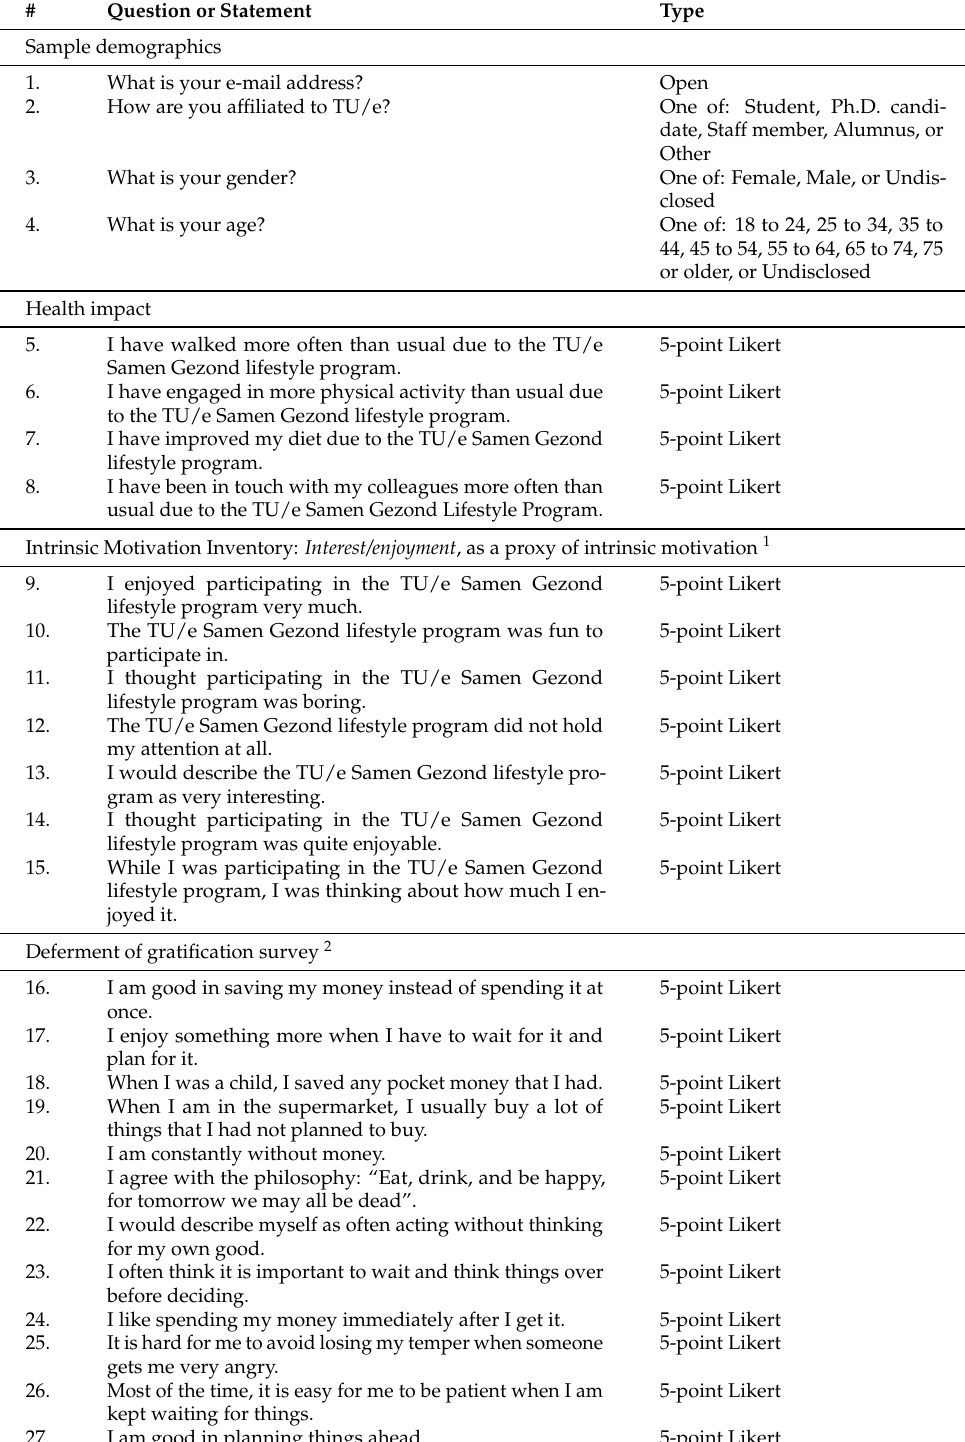
Table A2. Details of post-test survey 1